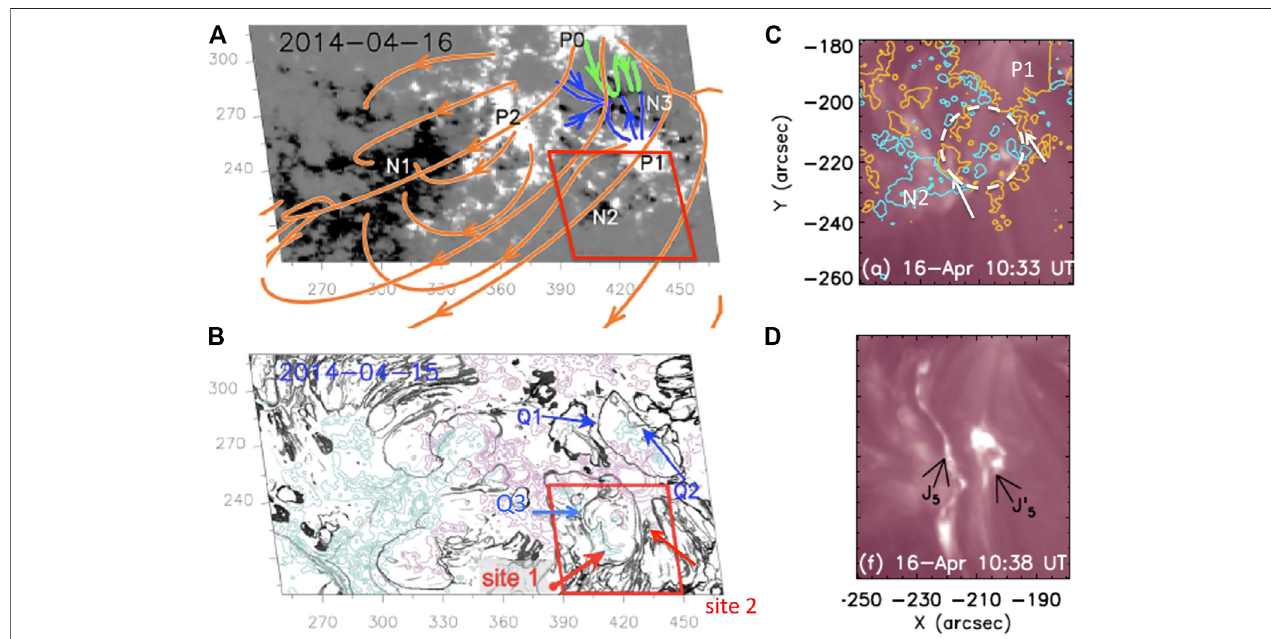
FIGURE 5 | Active region NOAA 12035 observed on April, 15 – 16 2014, (A) HMI magnetogram overlaid by extrapolated magnetic fi eld lines, (B) quasi separatrix layers(QSL)over themagnetic fi eldcontours;theredboxindicatesthetwositesofthereconnectionofthejets(redarrows). (C) Zoom onthemagneticregionformedby mixed emerging polarities (inside the white circle) between polarities P1 and N2. (D) Two parallel jets with origin in the two sites [adapted from Joshi et al.